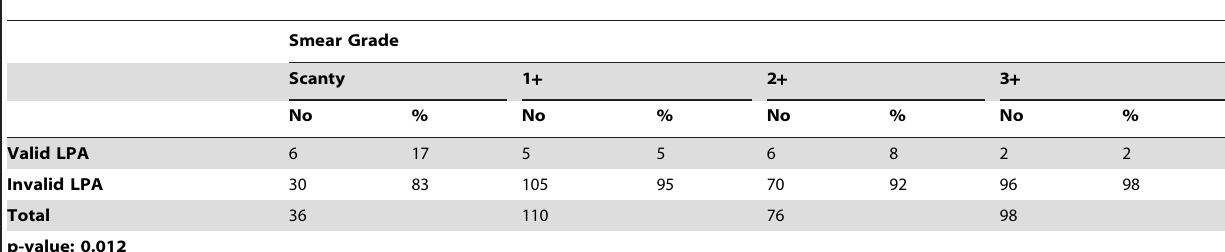
Table 2. Association between smear positivity grades and LPA test result.